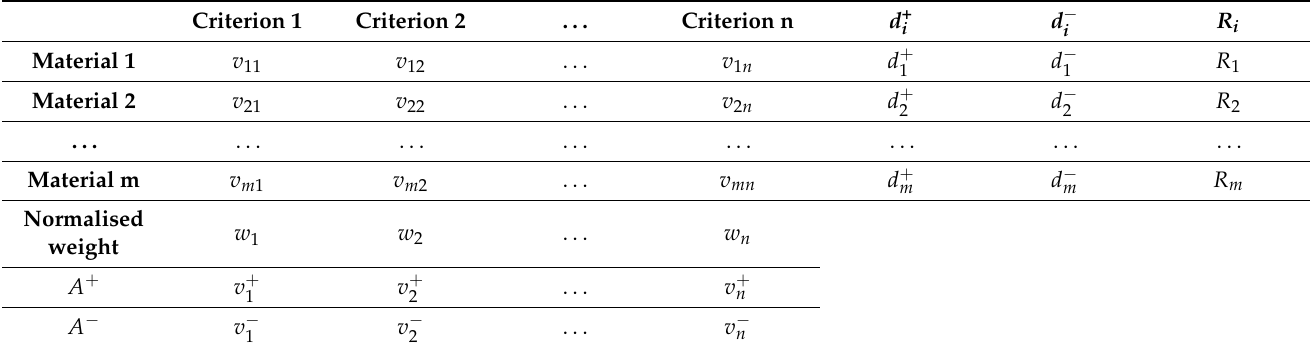
Table 5. Normalised matrix, ideal and anti-ideal solution, Euclidean distances and performances.